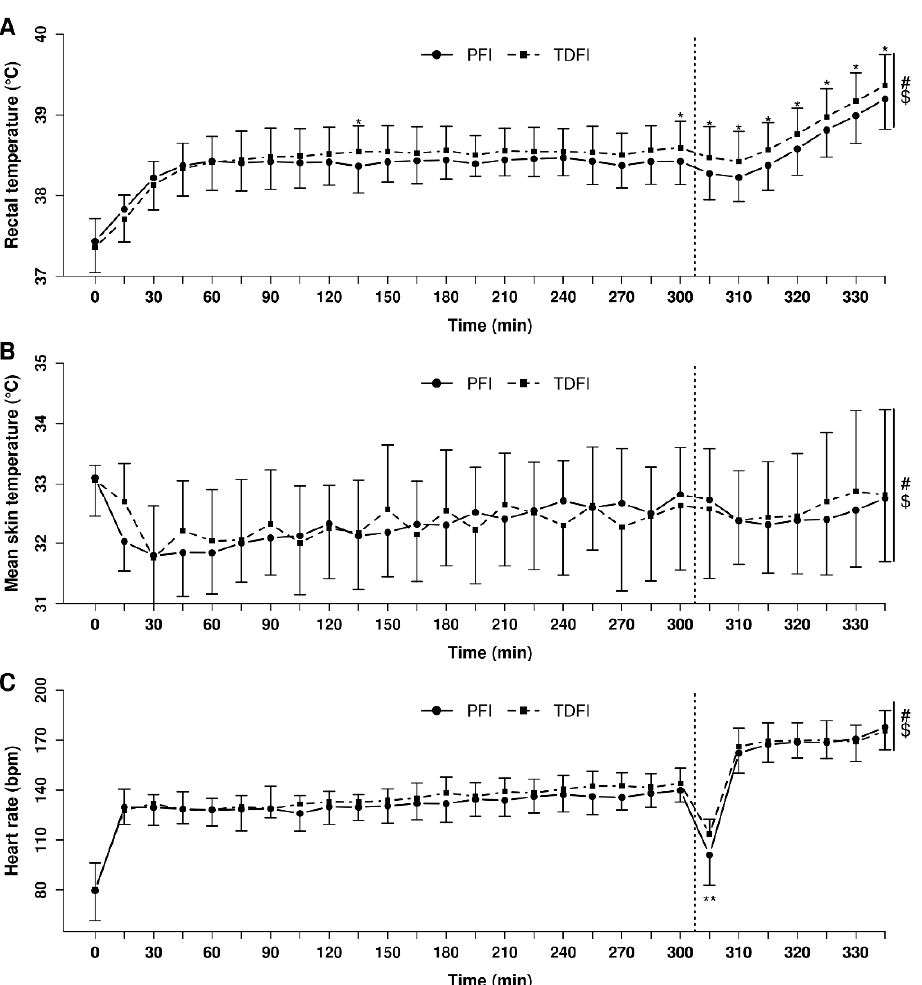
Figure 4. Heart rate ( A ), mean skin ( B ) and rectal temperatures ( C ) during the 5 h fixed-workload exercise period and 20 km time-trial for the programmed (PFI) and thirst-driven fluid intake (TDFI) strategies. * p < 0.05, ** p < 0.001 for difference between conditions, # significant time effect ( p < 0.001), $ significant interaction ( p < 0.05). Vertical dotted line represents the onset of the time-trial. Values are means ± SD.